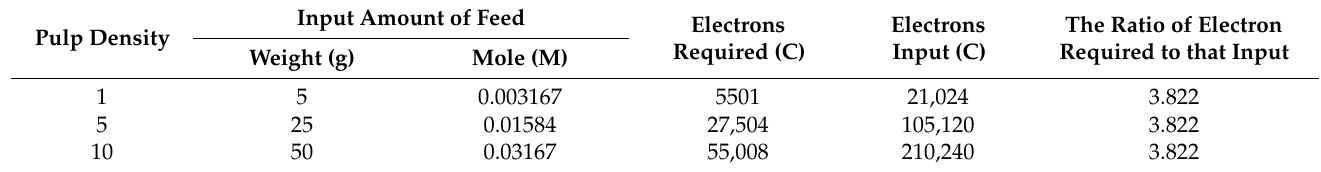
Table 2. The amounts of MoS 2 input, and electron required and applied.